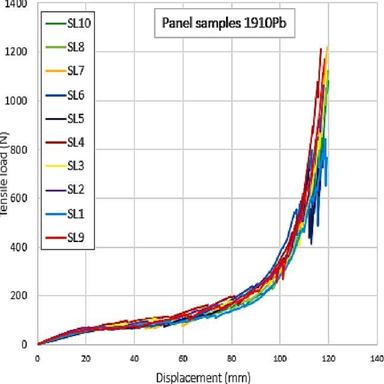
Representative example of the behavior curves of corrugated panels and measurements of their properties, as well as the behavior curves of ten 1910Pb panel samples under transverse tension loading.